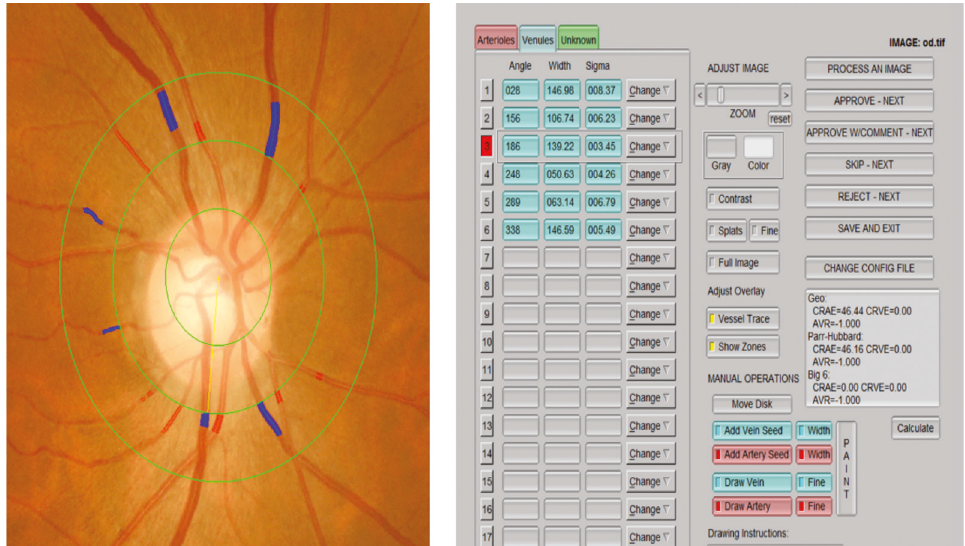
Figure 3: Retinal arteriolar and venular diameters. Semiautomated software (IVAN software, Australia) was used for the quantitative analysis. The software employs automatic optic disc detection and measures the calibre of six peripheral retinal arteriolar and venular vessel diameters up to 1DD from the optic disc margin. The major parameters: central retinal artery equivalent (CRAE), central retinal vein equivalent (CRVE), and arteriolar-to-venular diameter ratio (AVR). Measurements were taken within an area (0.5 – 1.0DD) centered on the optic disc.